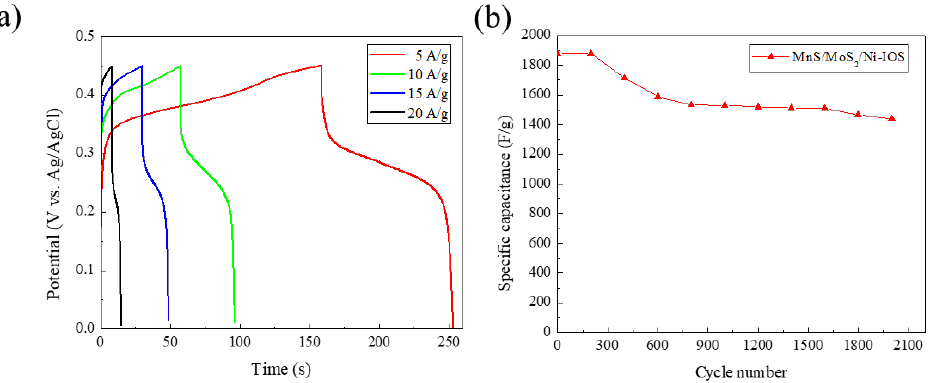
Figure 10. ( a ) The galvanostatic charge–discharge test (GCD) curves of the MnS/MoS 2 /Ni-IOS microelectrode samples with different charge–discharge currents, where the potential range was 0~0.45 V, and the current densities were 5 A/g, 10 A/g, 15 A/g, 20 A/g, respectively. ( b ) The cycle life test results of the MnS/MoS 2 /Ni-IOS microelectrode material prepared by using a current density of 5 A/g and a round number of 2000